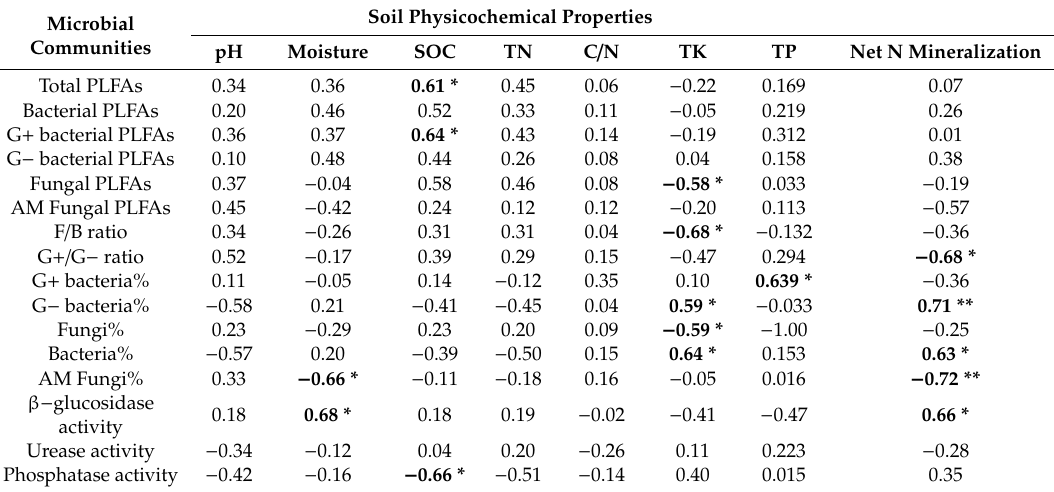
Table 4. Correlations analysis between indicators of soil microbial community, enzyme activity, and physicochemical properties in Chinese fir plantations with varying ages in Jiangxi Province. Microbial